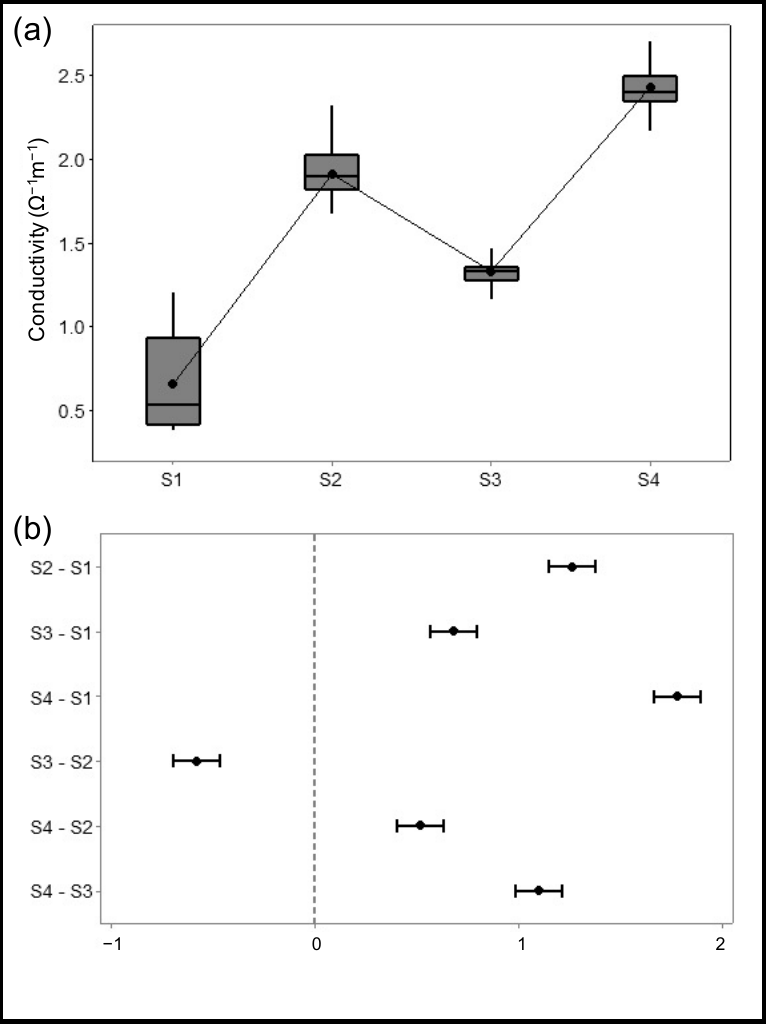
Figure 6. ( a ) Boxplots of conductivity results and ( b ) plot of Tukey’s test. Notes: Boxplots show the median, mean, interquartile range, and range from each solid fraction; if an interval in Tukey’s test plot does not contain zero, the corresponding means are significantly different.